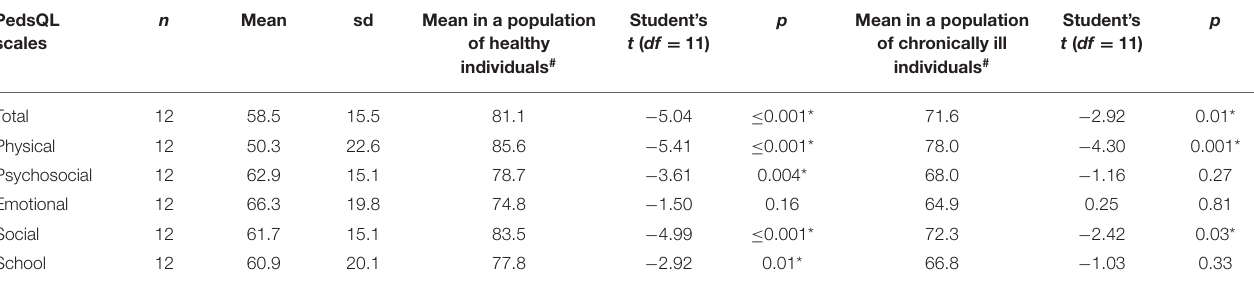
TABLE 4 | Data on children’s quality of life assessed using the Pediatric Quality of Life Inventory (PedsQL,) version 4.0, compared to standards obtained from a normal population and from a population of chronically ill children. n Mean sd Mean in a population PedsQL scales